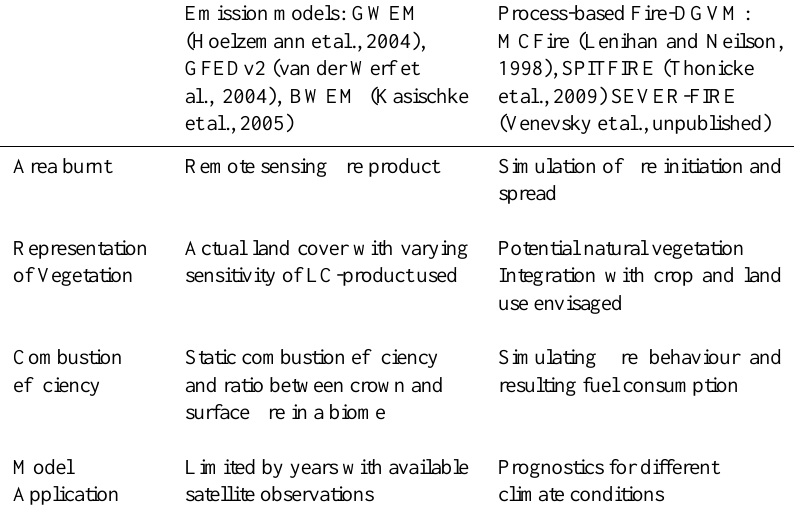
Table 2. Comparison of emission and process-based fire